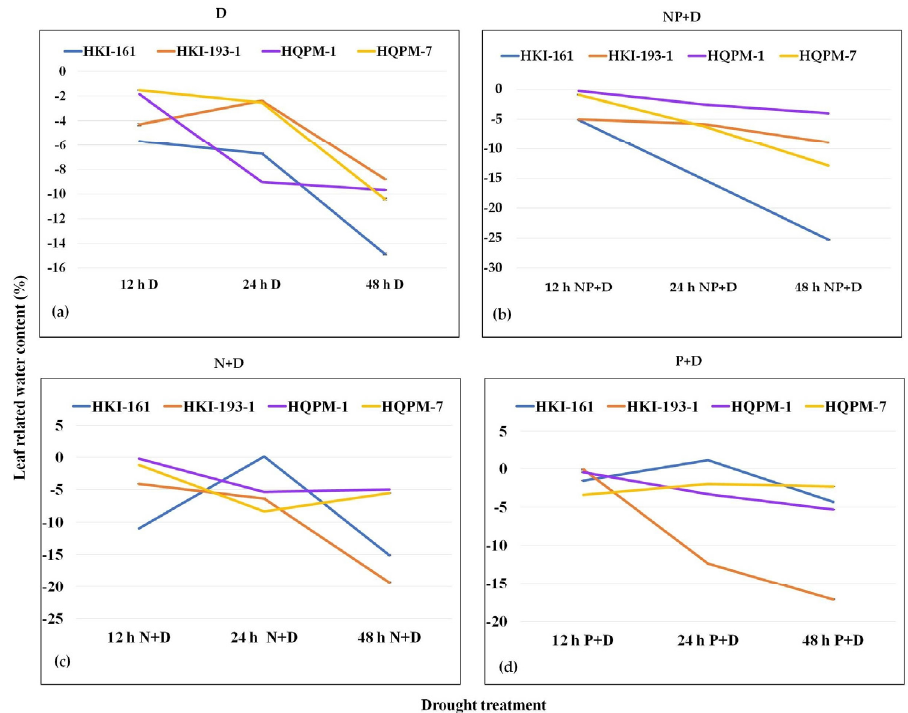
Figure 3. The effect of nutrient application on the changes in relative water content of maize leaves. Plants under drought-stressed (D) conditions ( a ) without nutrient pre-supplementation; ( b ) with pre-supplementation with both nitrogen (N) and phosphorous (P); ( c ) with pre-supplementation with only N; ( d ) with pre-supplementation with only P. The watered plants with and without N, P and NP pre-supplements were used as controls in respective case and used as reference for calculating the changes in different growth parameters. The mean values and standard error obtained using three biological replicates are plotted.